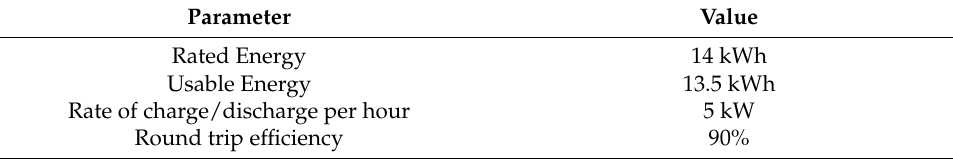
Table 2. Performance specifications of each